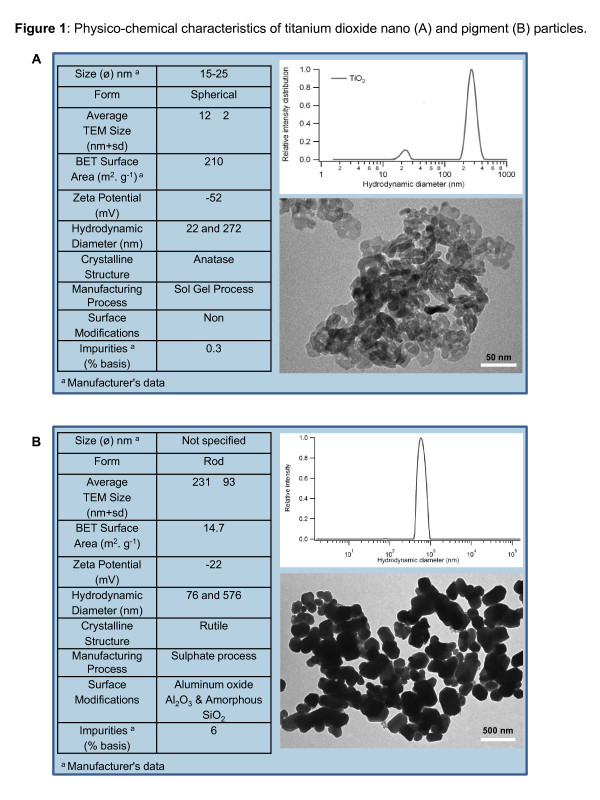
Physico-chemical characteristics of TiO
2
nano (A) and pigment (B) particles in powder and suspension.